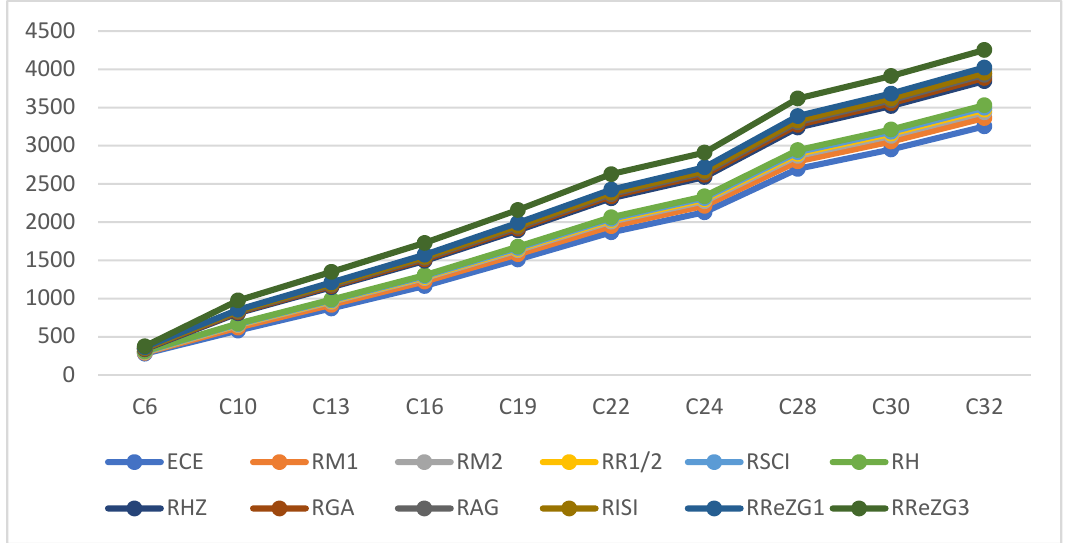
Figure 1. Variation of reverse topological descriptors and ECE.